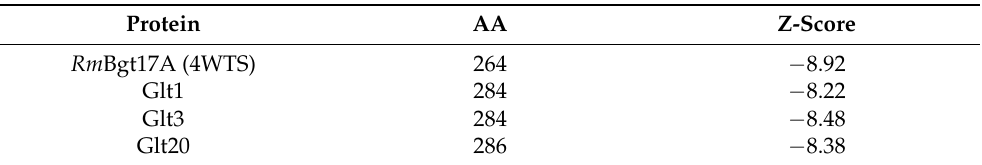
Table 2. Z-scores of the modeled enzyme structures, calculated by ProSA. The Z-score of the crystallographic structure of Rm Bgt17A used as the main template for building the hybrid models is included for